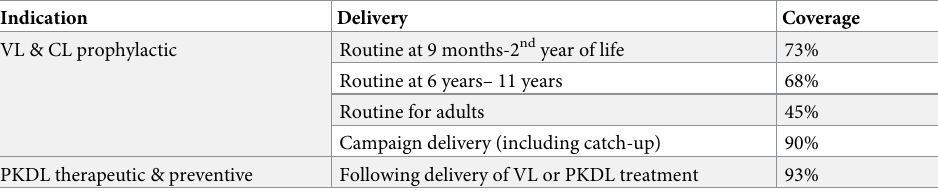
Table 2. Delivery strategy and related coverage assumptions (source: WHO/UNICEF coverage estimates for 2018, WHO Measles campaign overview